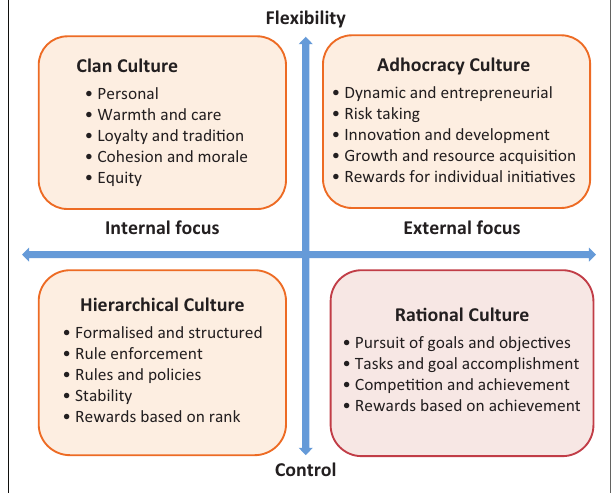
FIG URE 1: Competing values